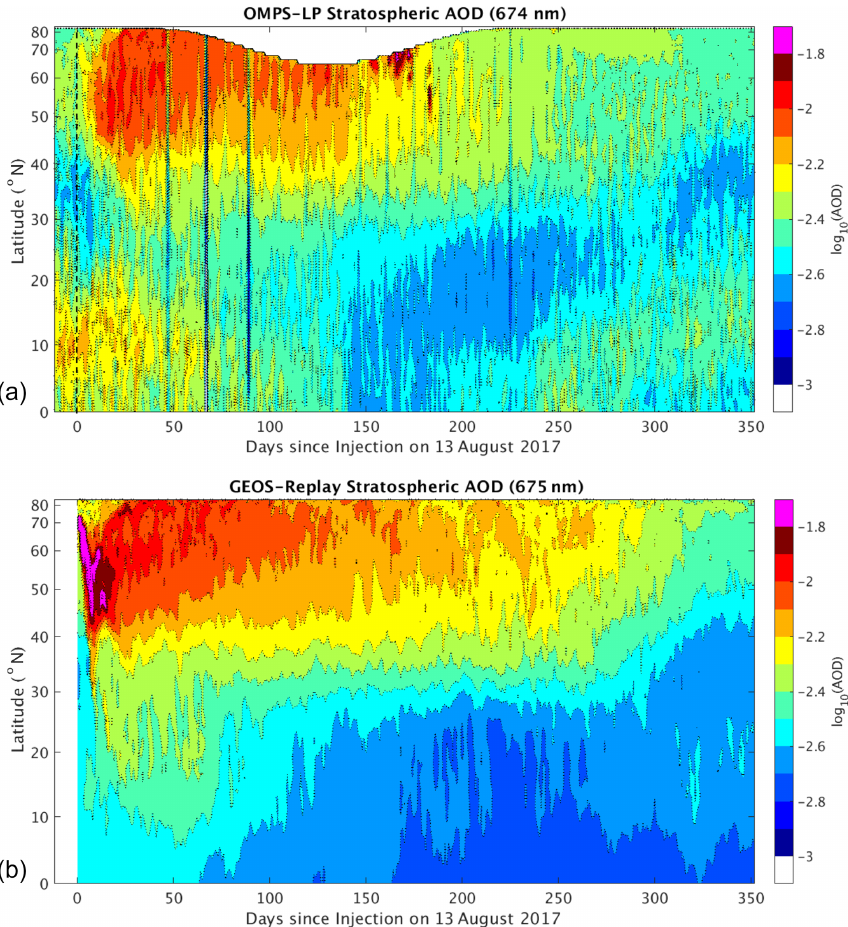
Figure 8. Hemispherical spread and residence time of aerosols. Zonal mean of total (smoke + background aerosol) stratospheric AOD (a) re- trieved from OMPS-LP and (b) simulated by the GEOS model for about a year after the injection on 13 August 2017. Note that enhanced AODs in the Arctic around day 150 are contribution from polar stratospheric clouds (PSCs) due to cloud-unfiltered OMPS-LP